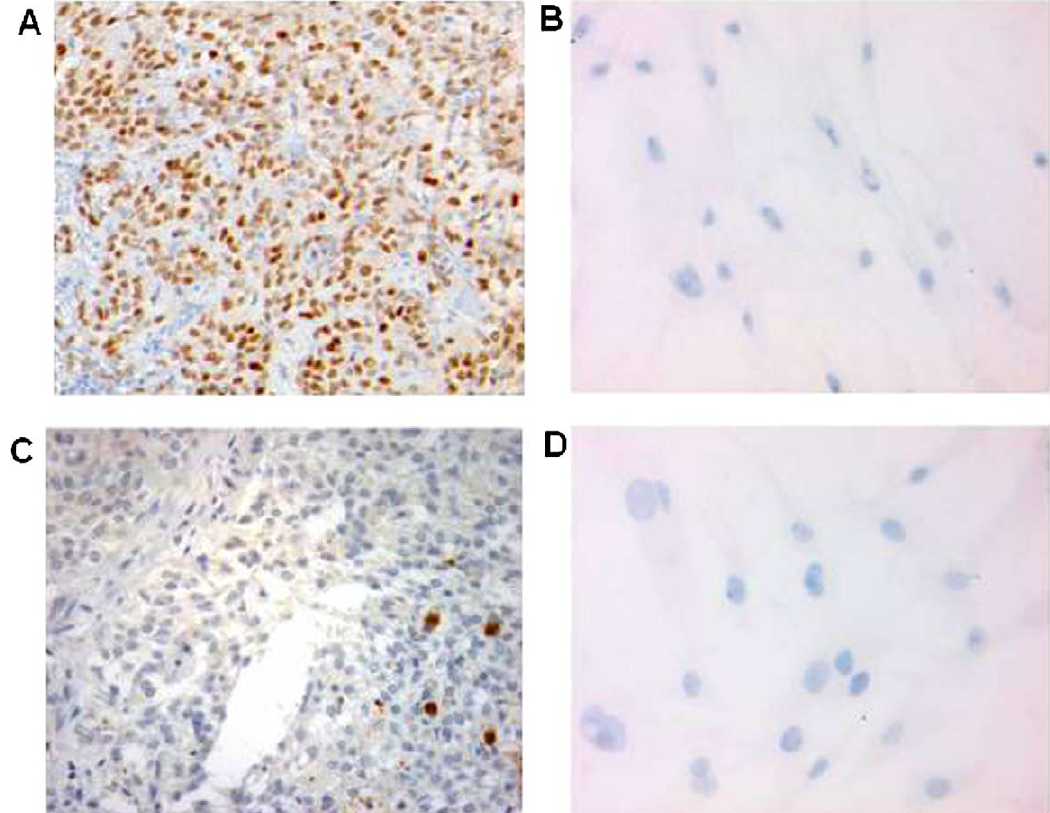
Fig. 2. Immunostaining of ER α (A and B) and ER β (C and D) in SPN tissue (left panels) and SPNC (right